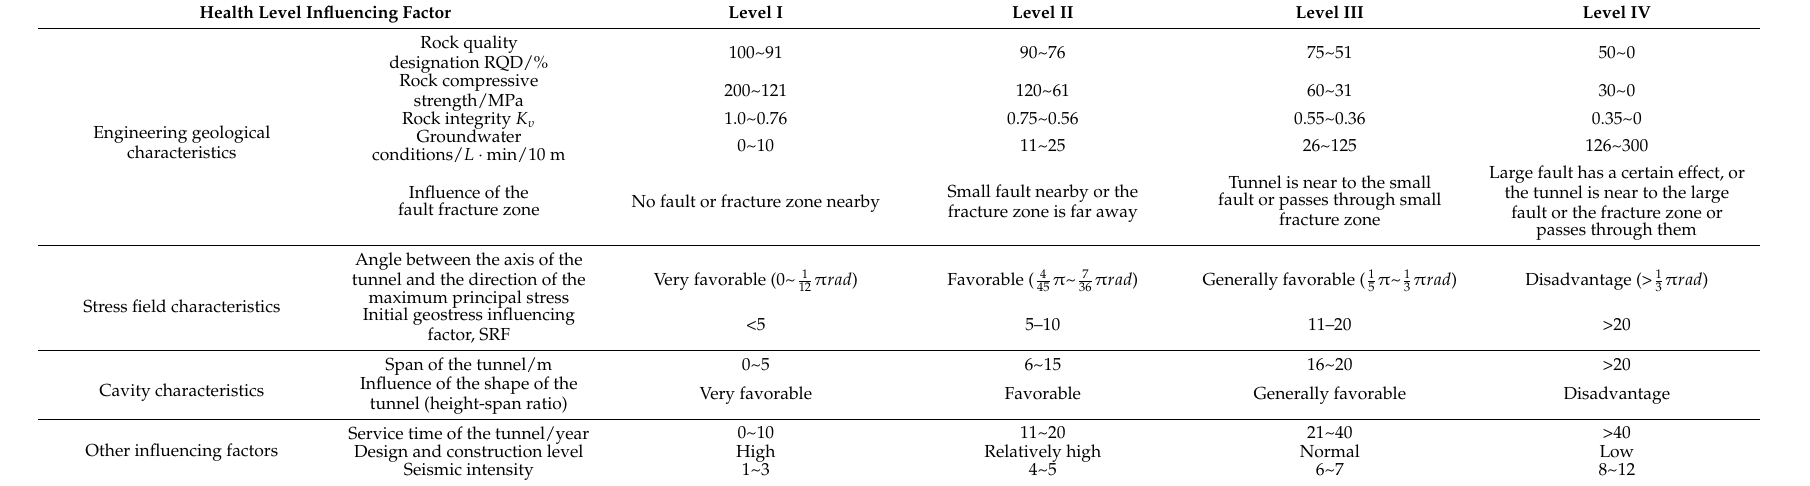
Table 4. Safety criterion value of other factors in evaluation